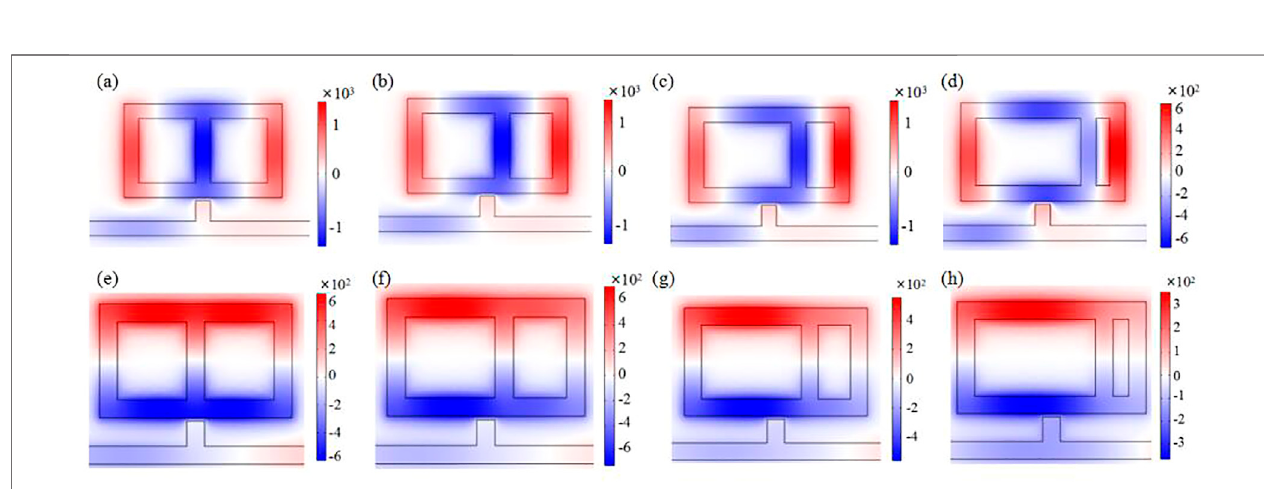
FIGURE7| TheH z fi elddistributionofstructurewith (A) S (cid:1) 0 nm; (B) S (cid:1) 50 nm; (C) S (cid:1) 100 nm; (D) S (cid:1) 150 nmatR2.theH z fi elddistributionofstructurewith (E) S (cid:1) 0 nm; (F) S (cid:1) 50 nm; (G) S (cid:1) 100 nm; (H) S (cid:1) 150 nm at R1.